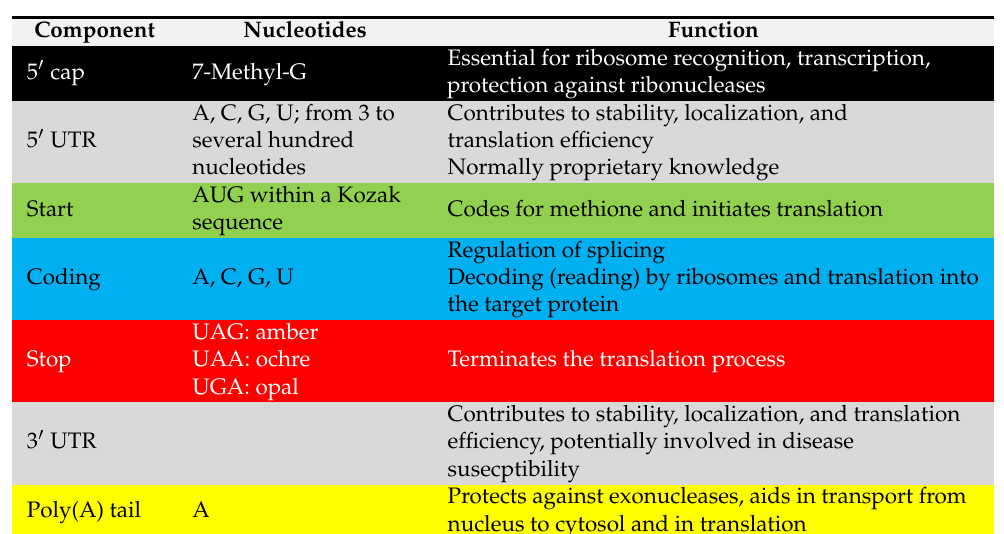
Table 1. Building blocks of mRNA and their functions. The Kozak sequence is a group of nucleotides that initiates the protein translation in the ribosome. An example is 5 (cid:48) -GCCGCCRCC AUG G-3 (cid:48) , where red color indicates that these nucleotides are fixed, AUG is the start codon encoding for methionine, R stands for A or G, and the function of GCC is not well